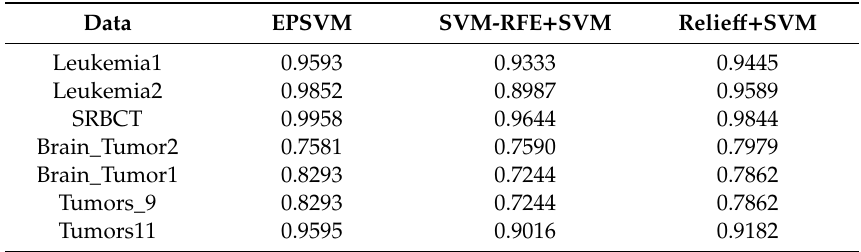
Table 9. NER of microarray data for tumor detection.